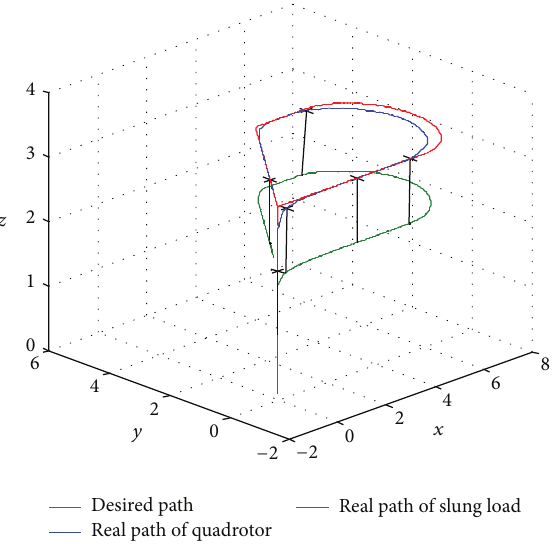
Figure 15: 3D flight of quadrotor with input shaping controller.